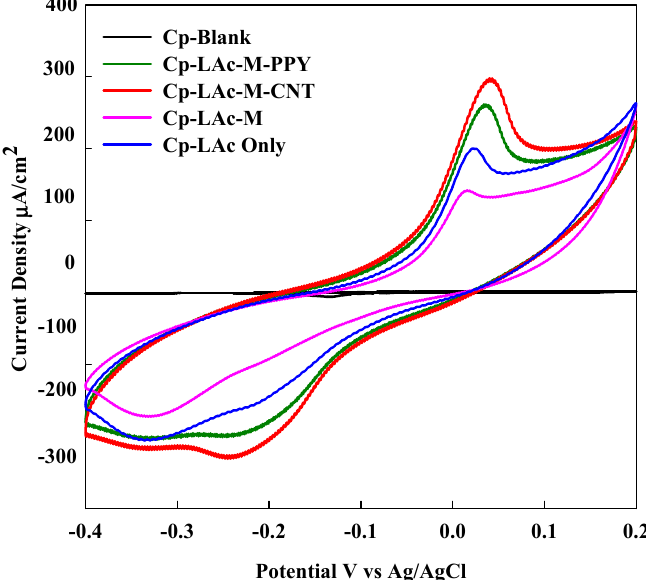
Figure 5. Voltammograms of the hydrophobic biocathode electrodes under 0.1 M PBS, pH 7, 37 °C, and O 2 saturation.